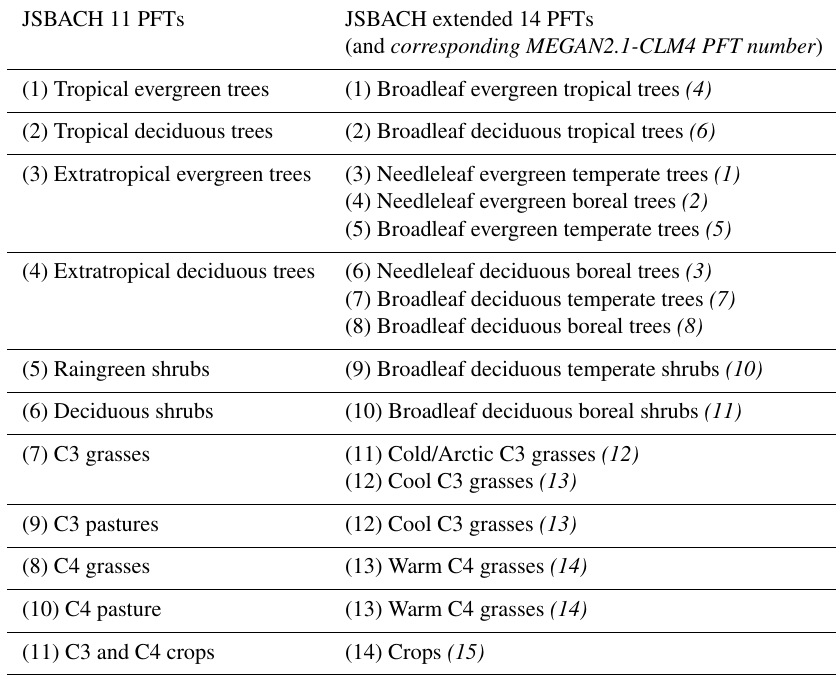
Table 2. Original (11-PFT) and extended (14-PFT) JSBACH PFT classifications for use in the biogenic emission module. The numbers of the corresponding 15 PFTs of the MEGAN2.1-CLM4 classification, as listed in Guenther et al. (2012), are given in italic in